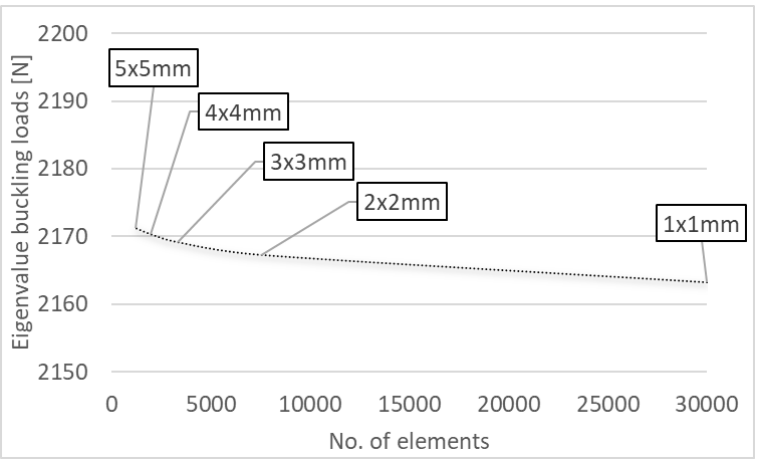
Figure 4. The convergence test results. Materials 2022 , 15 , 6938